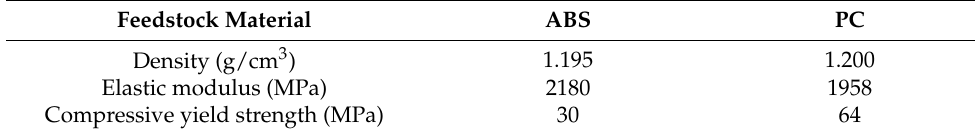
Table 2. Mechanical properties of ABS [60,61] and PC